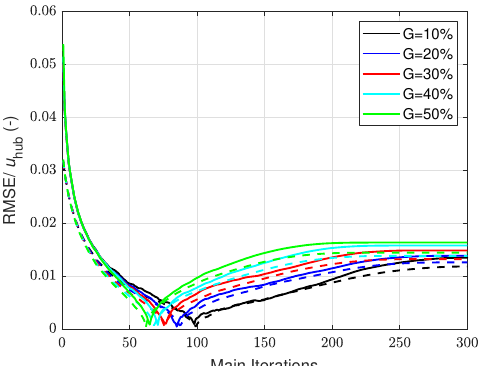
Figure 11. RMSE normalised with the hub height wind speed u hub as a function of main iterations for the CBL case (solid lines) and the SBL case (dotted lines) for different gappiness